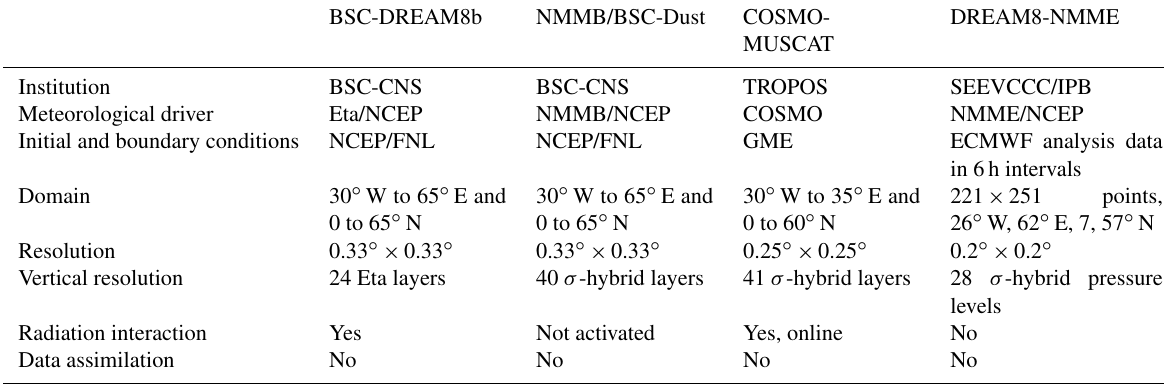
Table 2. Summary of the main parameters of the mineral dust transport models used in this study. BSC-DREAM8b NMMB/BSC-Dust COSMO- DREAM8-NMME MUSCAT Institution BSC-CNS BSC-CNS TROPOS SEEVCCC/IPB Meteorological